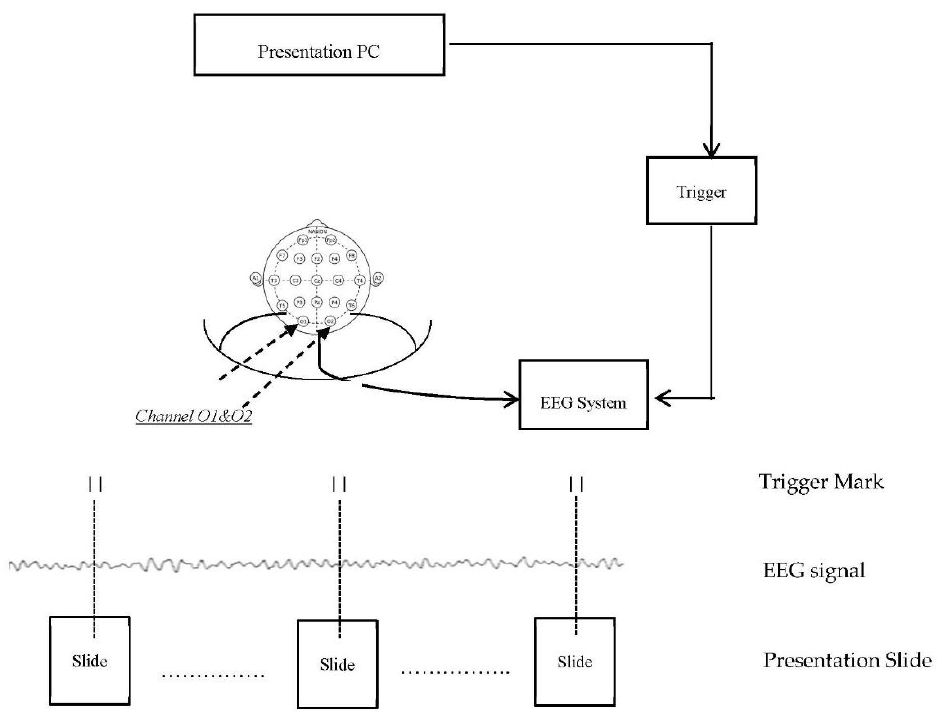
Figure 8. Setup of the EEG signal acquisition in the experiment.